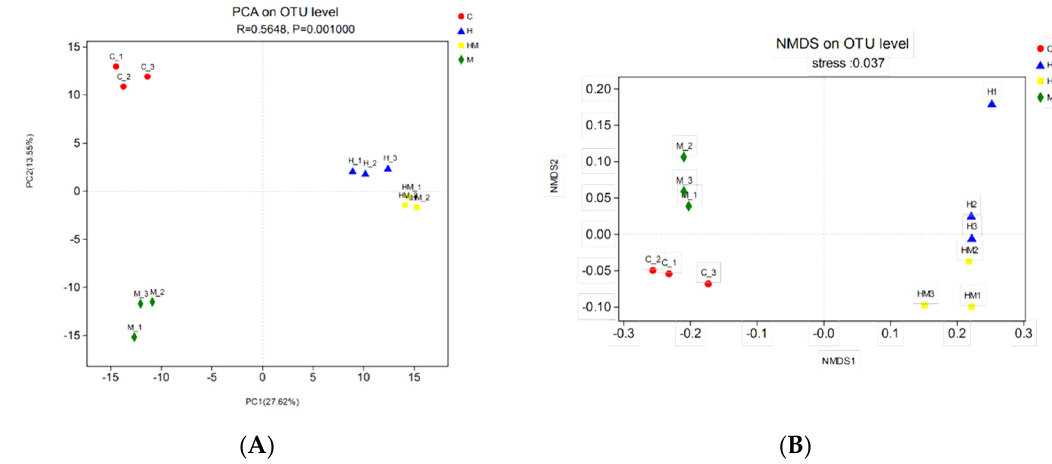
Figure 5. ( A ) Sample sorting analysis. The scatter plot of principal component analysis (PCA) scores shows the similarity of the twelve bacterial communities based on UniFrac distance. Principal components (PCs) 1 and 2 explained 27.62% and 13.55% of the variance, respectively. ( B ) Sample sorting analysis. Nonmetric multidimensional scaling (NMDS) shows the difference among bacterial communities according to Bray–Curtis distance. H, hydramethylnon sample; M, M. anisopliae sample; HM, hydramethylnon and M. anisopliae sample; C, control sample.